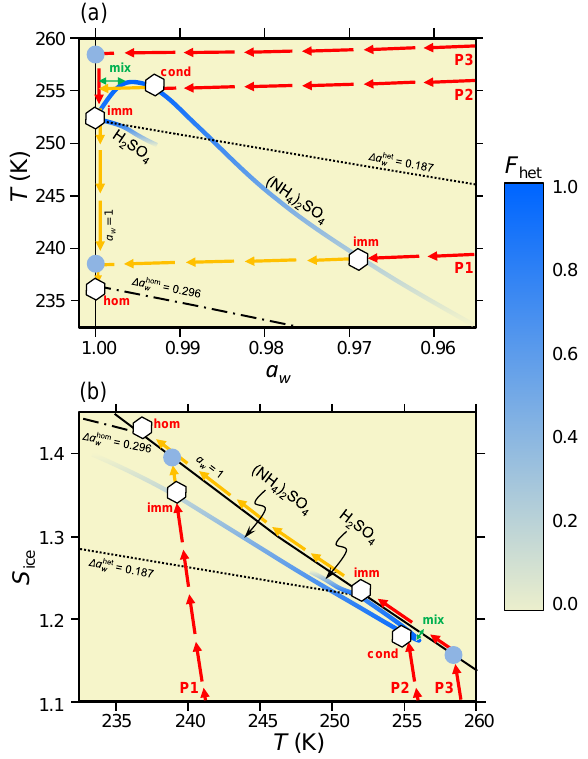
Figure 9. Phase diagrams a w − T (a) and T − S ice (b) , showing the development of aerosols containing microcline in dry (P1), moist (P2) and wet (P3) air parcels undergoing adiabatic cooling (red arrows) until ice nucleates (white hexagons). Blue curves: hetero- geneous freezing onset temperatures, T het , of 2wt% microcline suspended in aqueous ( NH 4 ) 2 SO 4 or H 2 SO 4 solutions. Color cod- ing: heterogeneously frozen fraction, F het , ranging from high (blue) to vanishing (yellow). In aqueous ( NH 4 ) 2 SO 4 , ice can nucleate heterogeneously on microcline. In aqueous H 2 SO 4 , microcline is largely deactivated and ice nucleates homogeneously only after further cooling (yellow arrows) and forming a supercooled liquid cloud (filled blue circles). Solid black line: water saturation ( a w = 1, RH = 100%). Dash-dotted black line: homogeneous ice nucleation, horizontally shifted from the ice melting curve by a constant offset (cid:49)a hom w = 0.296. Dotted black line: shifted by (cid:49)a het w = 0.187 derived from microcline suspended in pure water. Atmospheric freezing modes: “imm” = immersion; “cond” = condensation; “hom” = homogeneous. Entrainment/detrainment at cloud edges may cause nucleation at up to 4K higher temperature than “imm” (green double arrow,